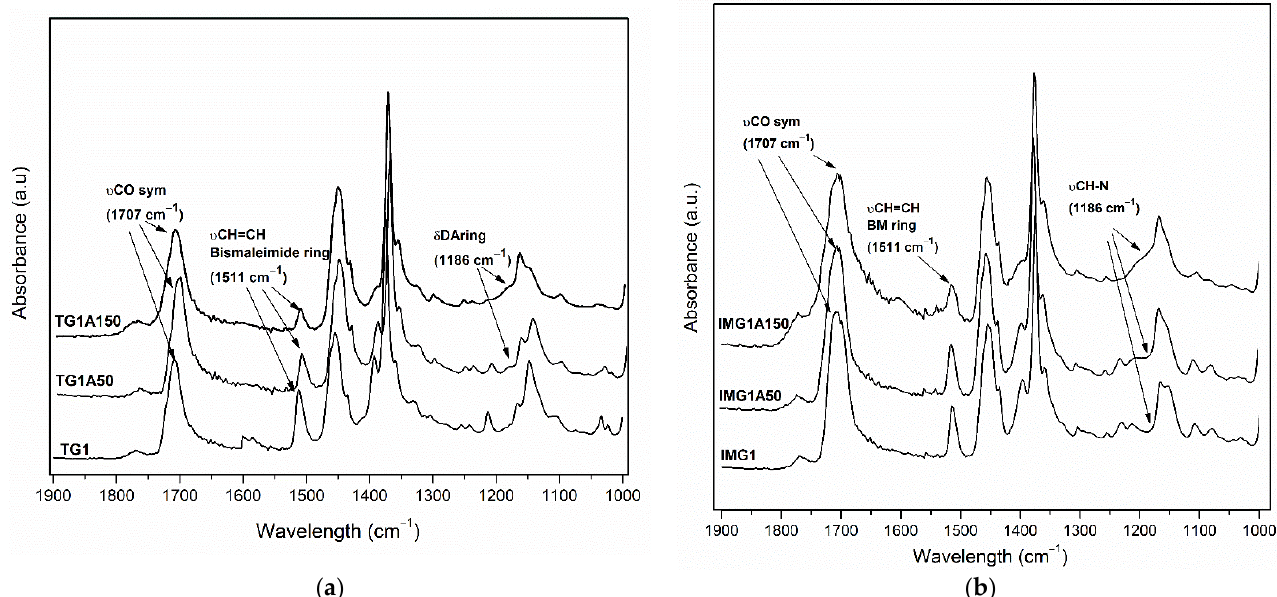
Figure 3. FTIR spectra of the products after Diels – Alder reaction with thiophene ( a ) and imidazole ( b ) and annealing with different temperatures in the absorption range of 1000 − 1900 cm − 1 .